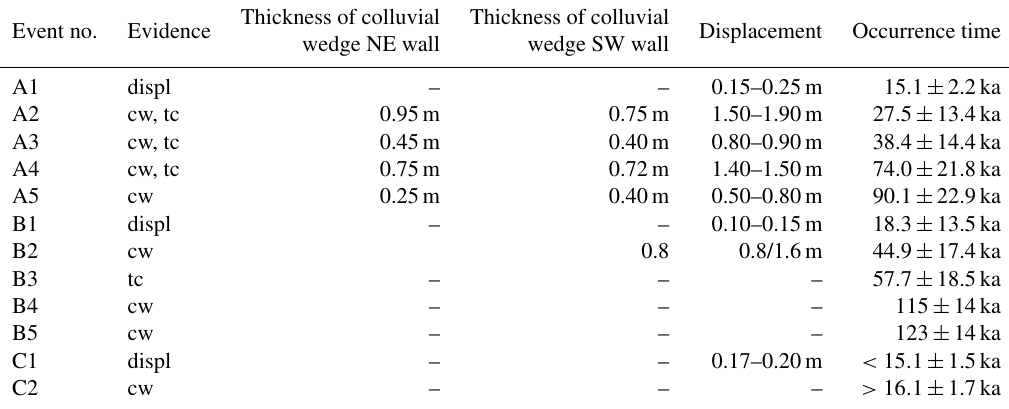
Table 2. Type of evidence, inferred displacement for the palaeoearthquakes A1 to A5 (trench SDF1), B1 to B5 (SDF3), and C1 to C2 (WAG) and possible occurrence